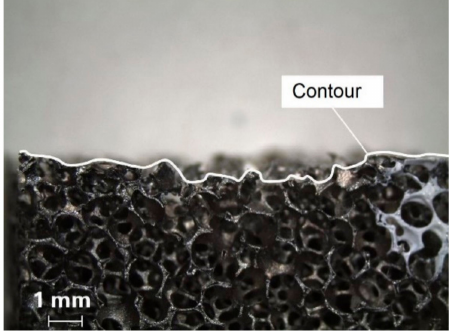
Figure 3. Profile of machined surface of a cellular material.